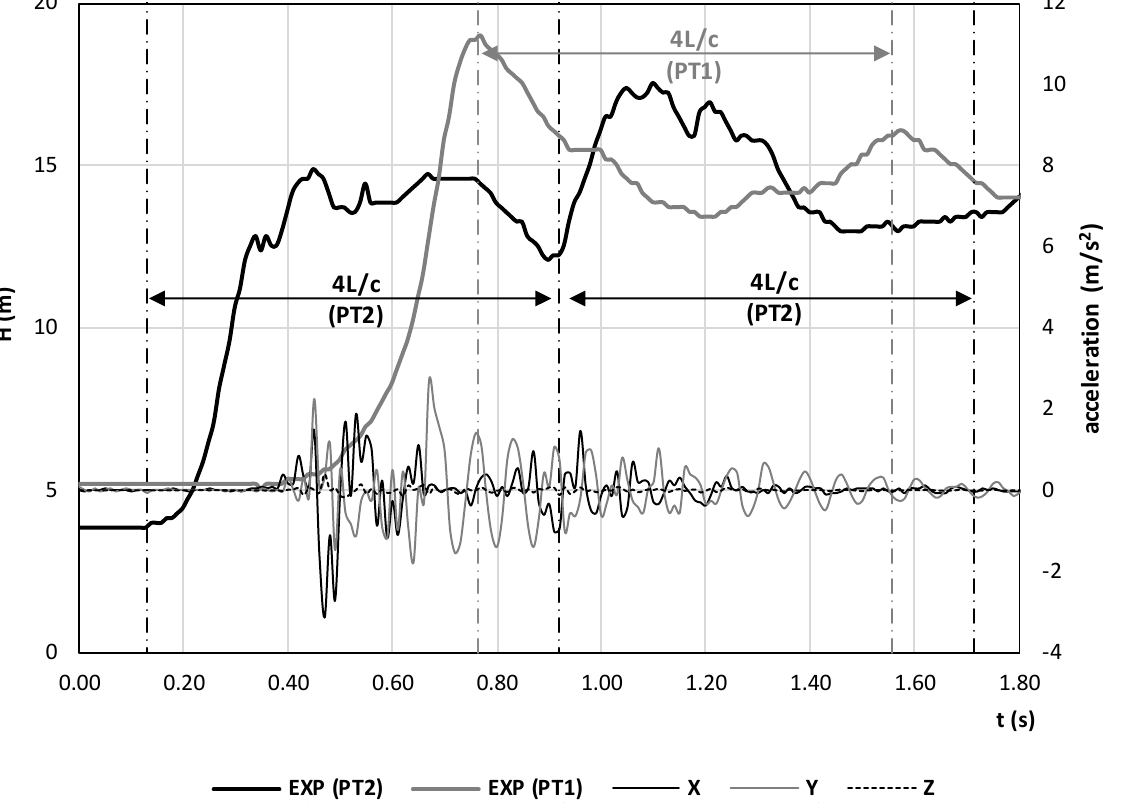
Figure 3. Pressure variation (m) and pipe vibration (in acceleration